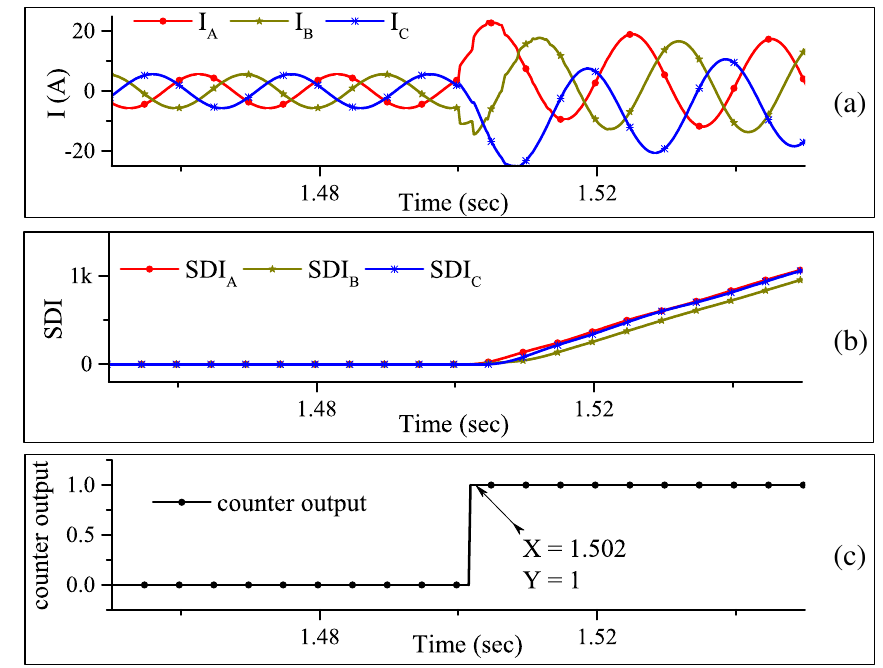
Fig. 7 Fault happened nearby terminal, ( a ) Current waveforms, ( b ) SDI trajectories ( c ) counter